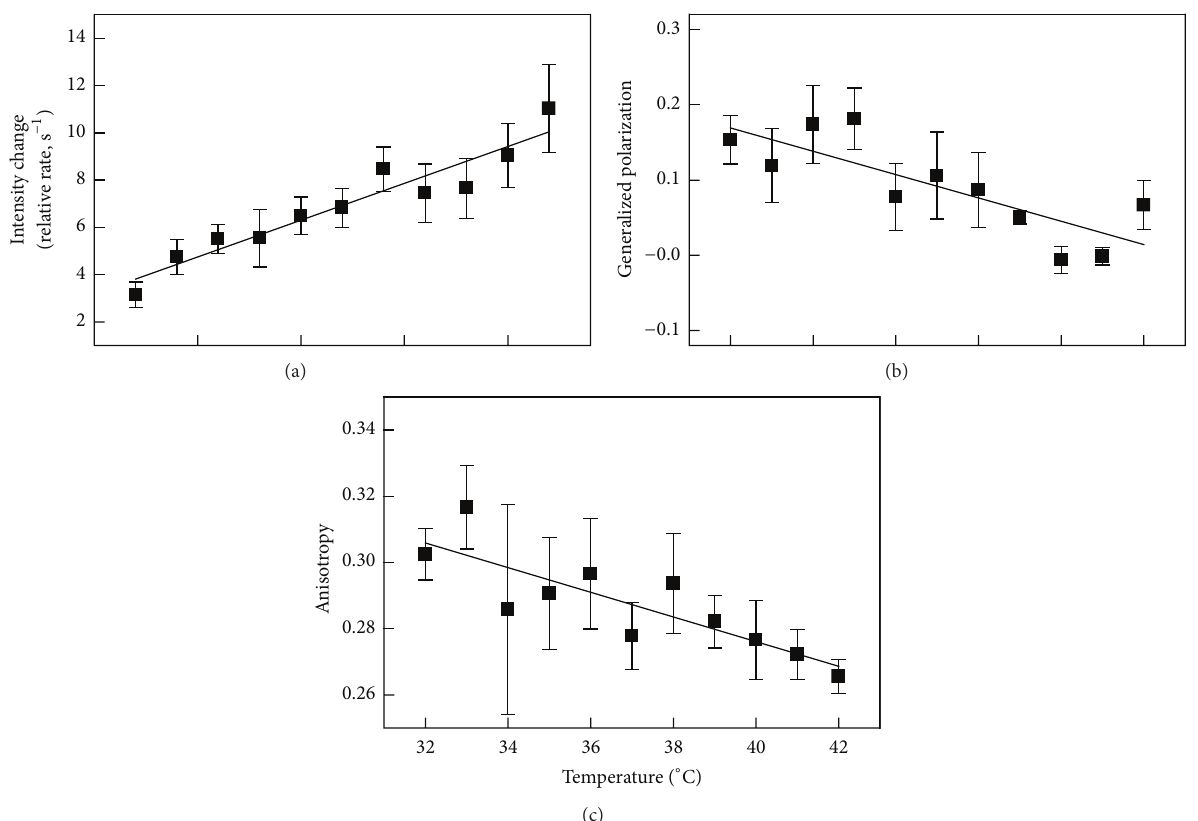
Figure 4: Relationship between the rate of microparticle release and membrane order as a function of temperature. (a) The relative rate of particle release upon addition of ionomycin was calculated from experiments such as that shown in Figure 2. Cells were equilibrated at 37 ∘ C and then adjusted to the indicated temperature and equilibrated for 10min prior to adding ionomycin. The relative rate of release was determined from the maximum slope of the time profile following ionomycin addition and normalized to initial light scatter intensity as in Figure 3. Based on linear regression, the positive trend was significant ( 𝑃 < 0.0001 , 𝑟 2 = 0.28 , 𝑛 = 5 –15 per temperature, 83 total values). ((b)-(c)) The experiments of (a) were repeated with cells labeled with patman (b) or TMA-DPH (c). Nonlinear regression to an arbitrary function (sum of two exponentials) was used to smooth the Patman data prior to calculating the value of GP or TMA-DPH anisotropy was averaged from 7 points prior to addition of ionomycin. The negative trends in both cases were significant by linear regression ( 𝑃 ≤ 0.006 , 𝑟 2 > 0.21 , and 𝑛 = 3 per